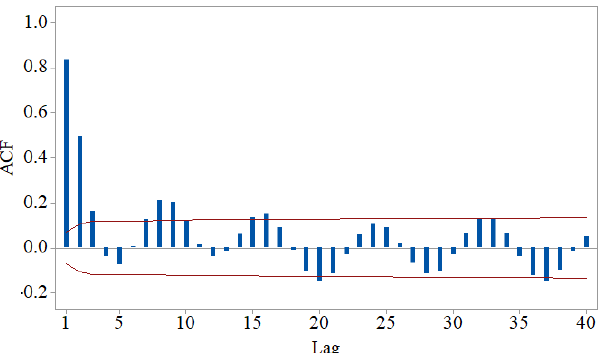
Figure 5. Charts of the sig nal autocorrelation function (ACF) (obtained using Minitab17)